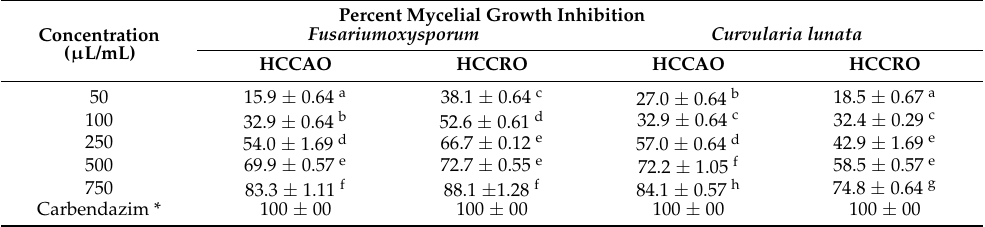
Table 14. Percent mycelial growth inhibition of F. oxysporum , and C. lunata by HCCAO and HCCRO. Percent Mycelial Growth Inhibition Concentration ( µ